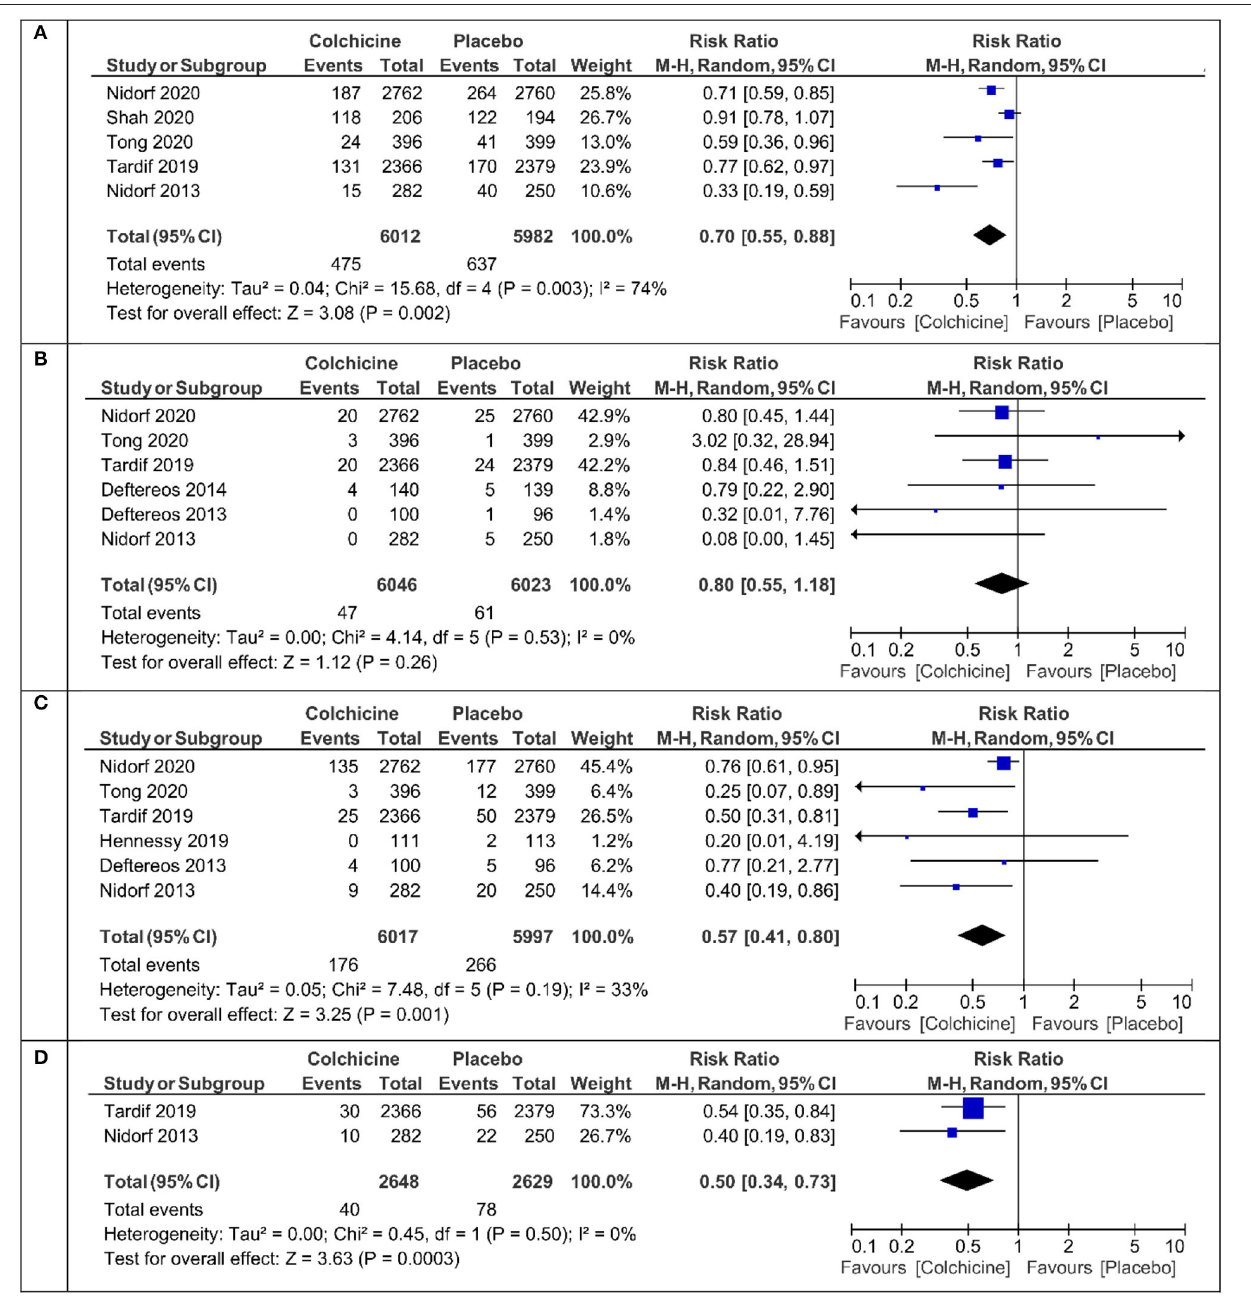
small observational clinical trials, 11,790 patients were included in the sensitivity meta-analysis and the results were almost identical to those in the main meta-analysis ( Supplementary Material ). This confirms the reliability and robustness of the obtained